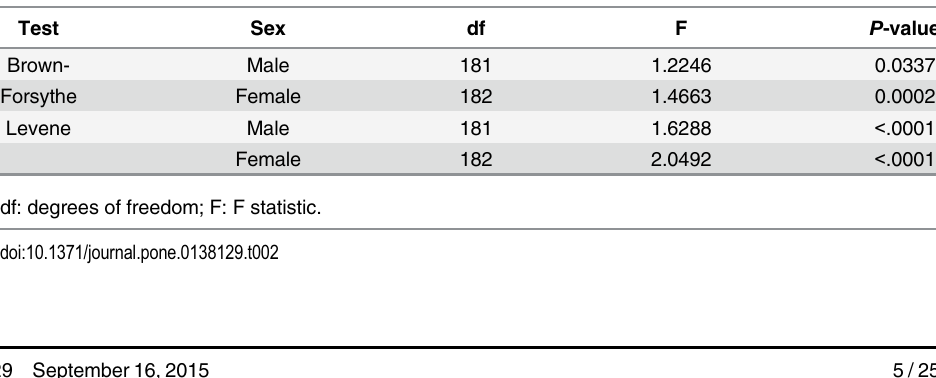
Table 2. Brown-Forsythe and Levene ’ s tests for unequal